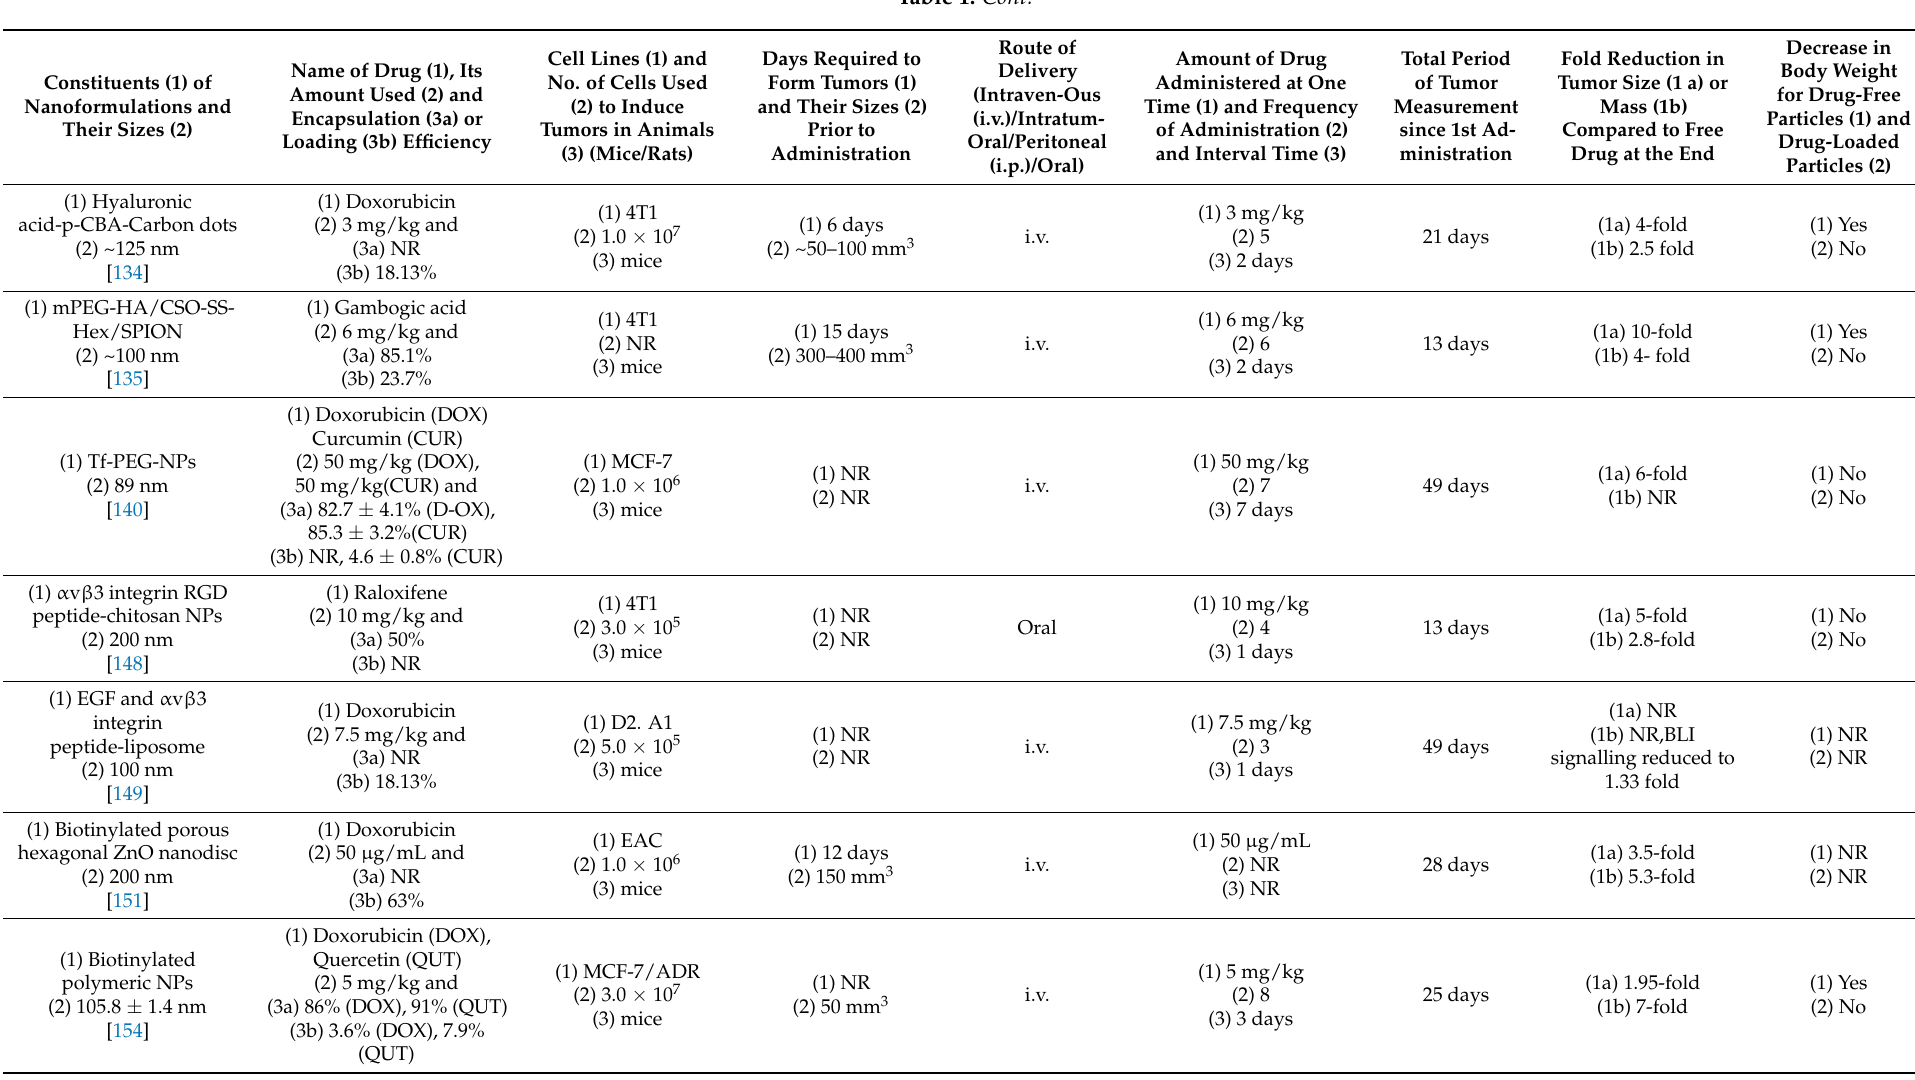
Constituents (1) of Nanoformulations and Their Sizes